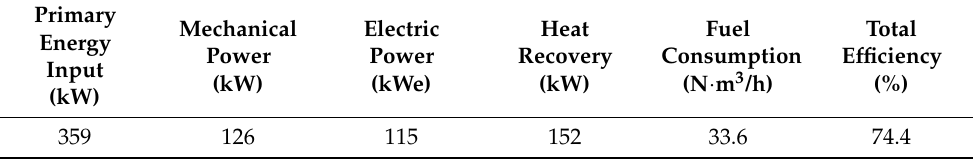
Table 1. Specifications of gas engine CCHP system used in the present